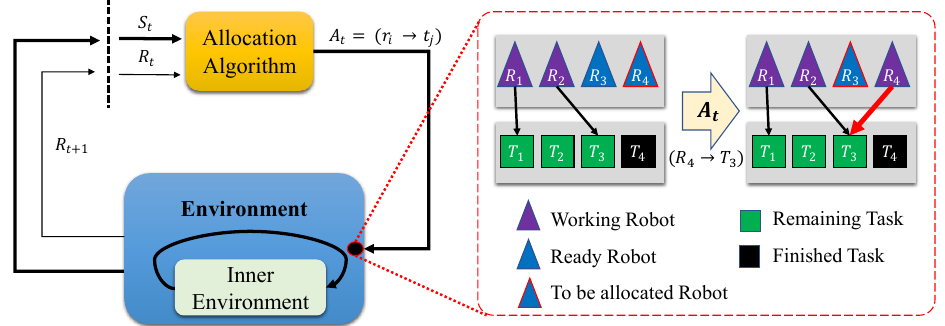
Figure 2. A single time step of the allocation environment. When the allocation algorithm gives action A t to the environment, the environment gives the next state and reward pair ( S t + 1 , R t + 1 ) . When we simulate the environment, robots { R 1 , R 2 , R 3 , R 4 } choose actions in the inner environment which is also form of MDP. The allocation algorithm decides which task t j in T remaining is assigned to the given robot r i in R ready . In this example, R ready = { R 3 , R 4 } , T remaining = { T 1 , T 2 , T 3 } , and the given robot is R 4 . The algorithm allocates the robot R 4 to task T 3 . After allocation, the inner environment runs until there is another ready robot. In this case, robot R 3 is another ready robot and next allocation happens immediately. Best viewed in